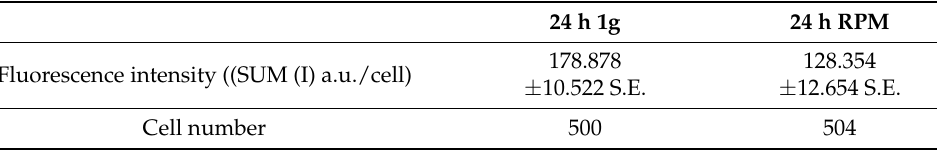
Fluorescence intensity ((SUM (I)